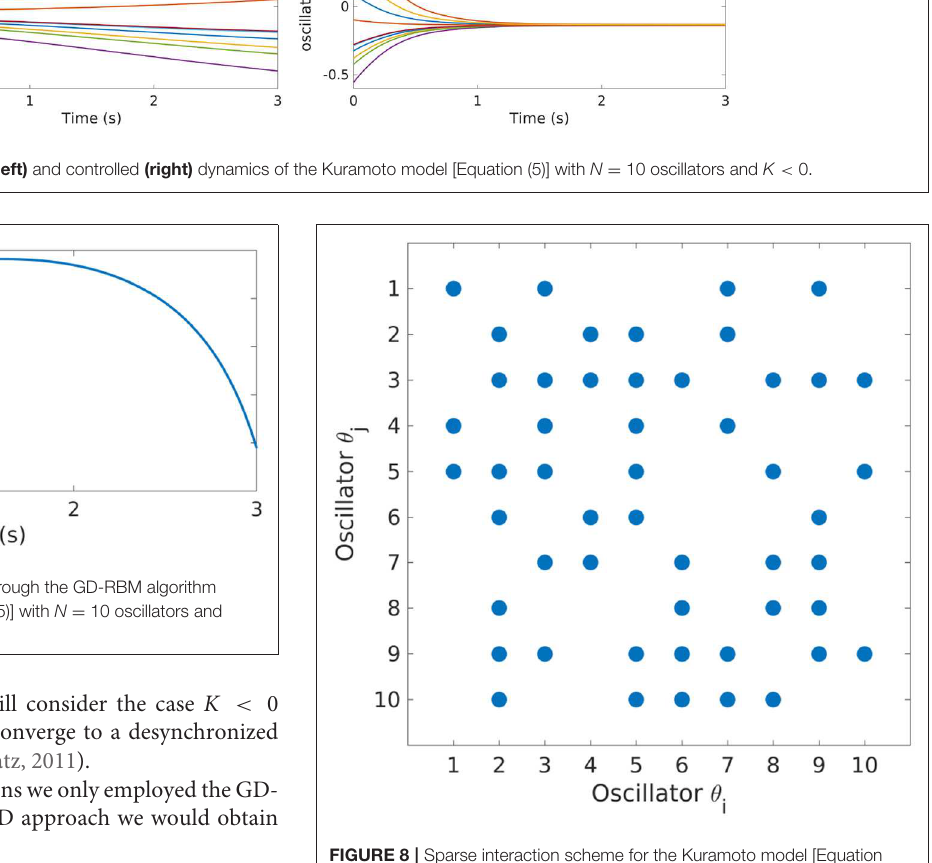
10 oscillators and =